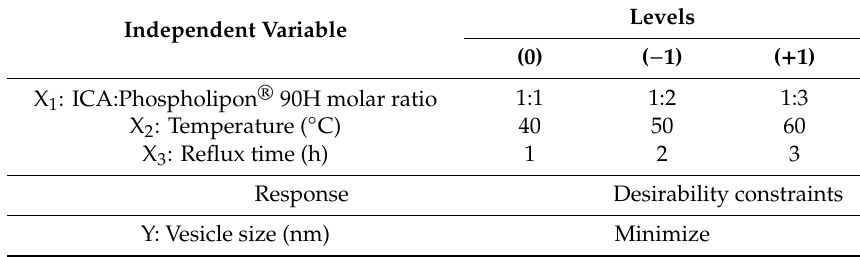
Table 1. Independent variables and responses of Box–Behnken design employed for the formulation of ICA-phytosomes.